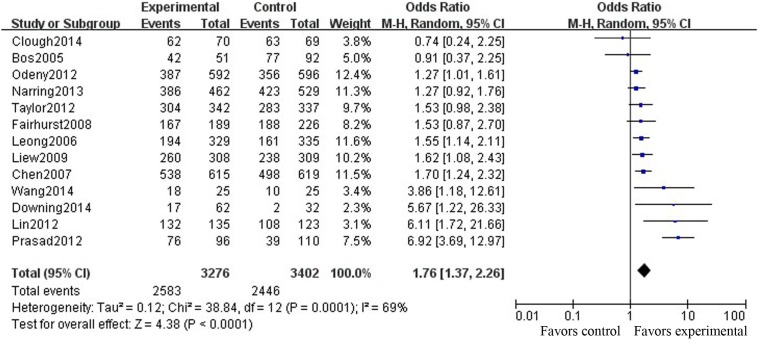
Comparison of the FUR between the SMS and the control groups.